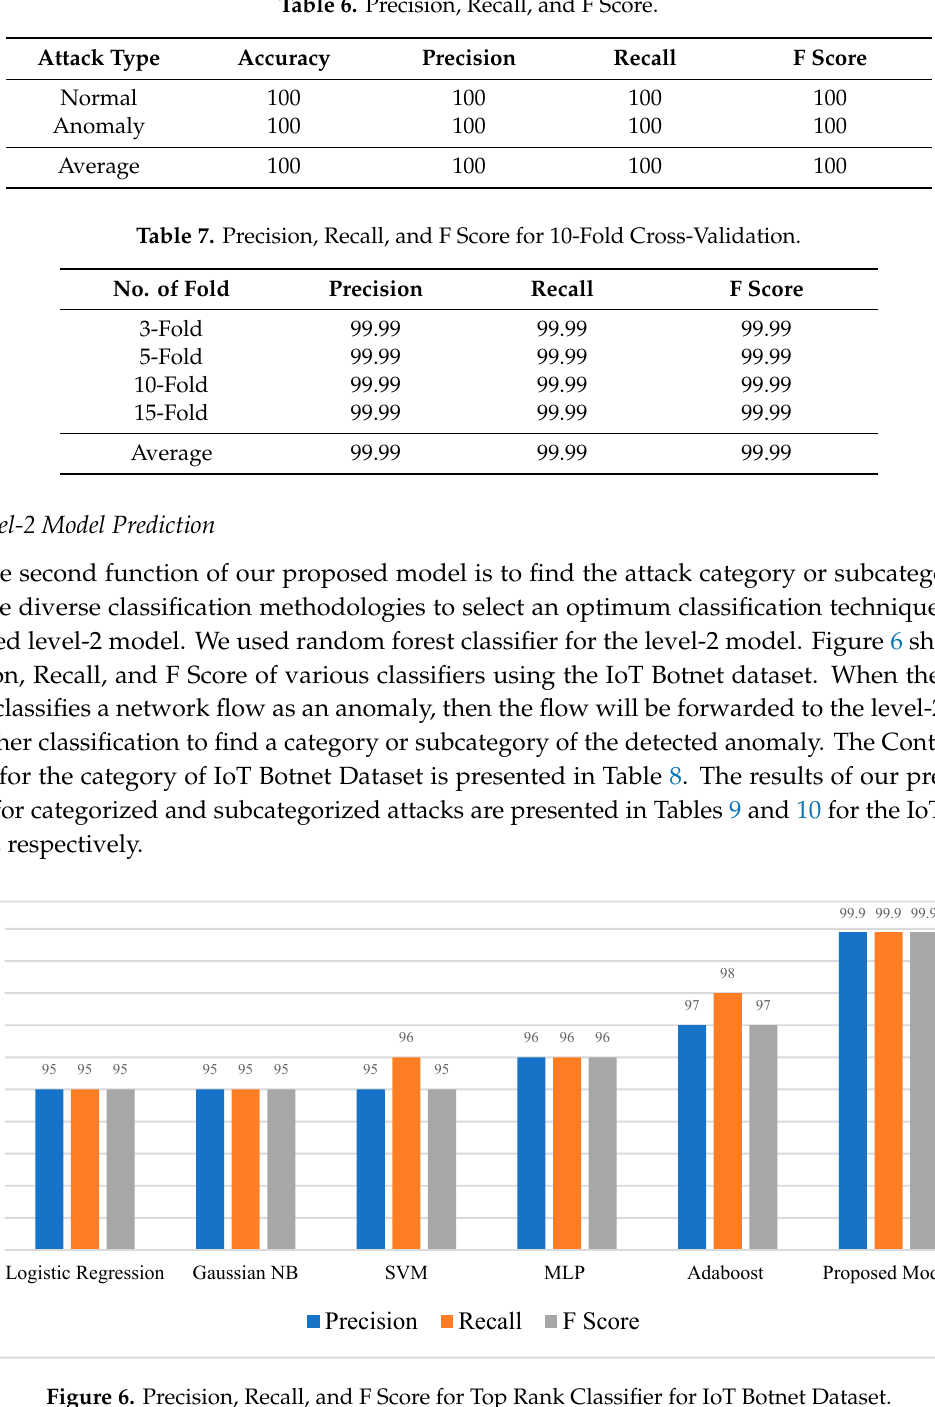
Figure 6. Precision, Recall, and F Score for Top Rank Classifier for IoT Botnet Dataset. Table 8. Contingency Matrix for Category.